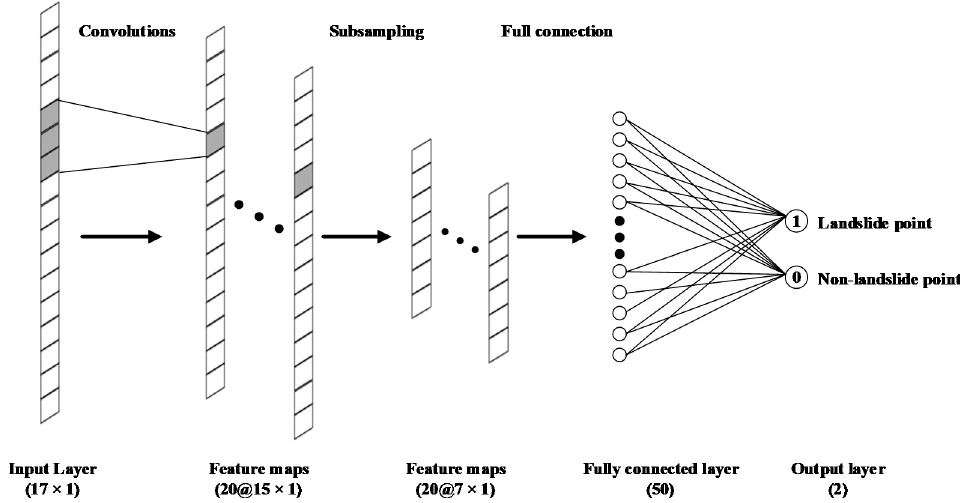
Figure 8. Structure of the constructed convolutional neural network (CNN) model.